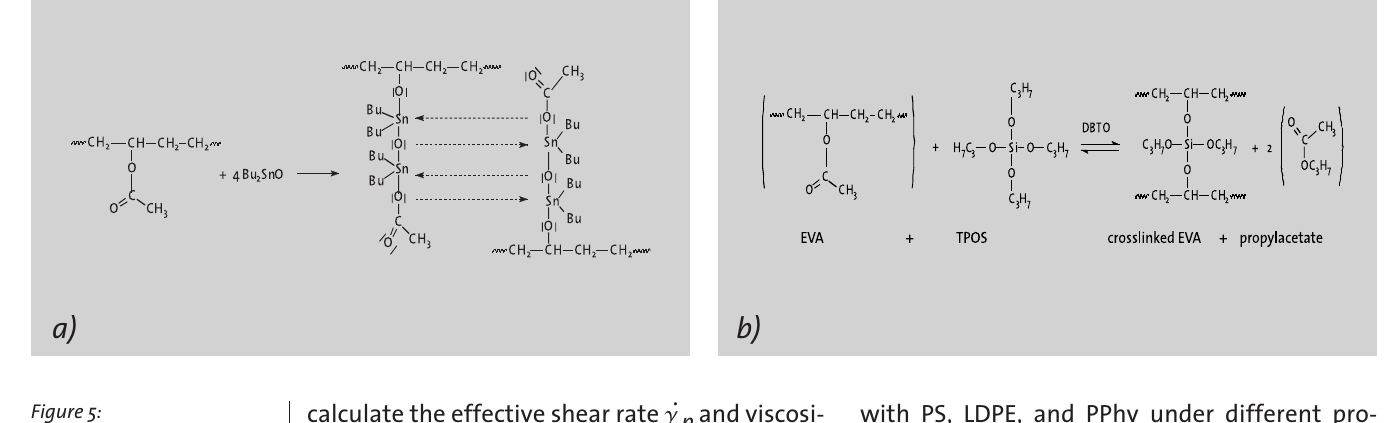
Figure 5: Crosslinking reaction of EVA: a) Formation of the real catalyst between EVA and DBTO, b) Crosslinking of EVA by exchange reaction with